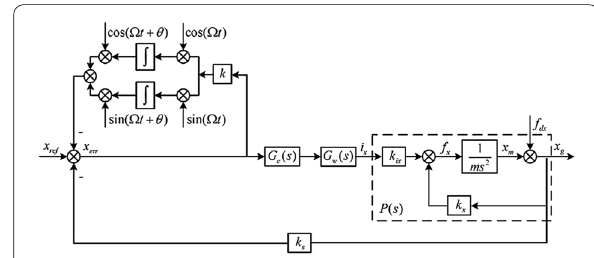
Figure 22 Bock diagram of MSR system synchronous vibration management supported section shift notch